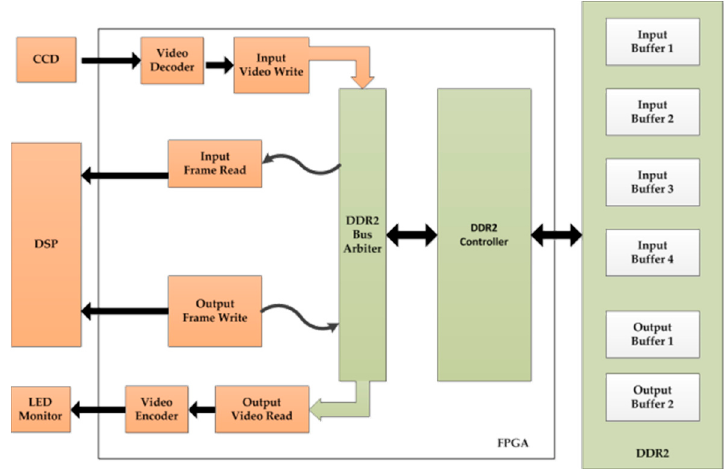
Figure 8. Underlying data flow architecture